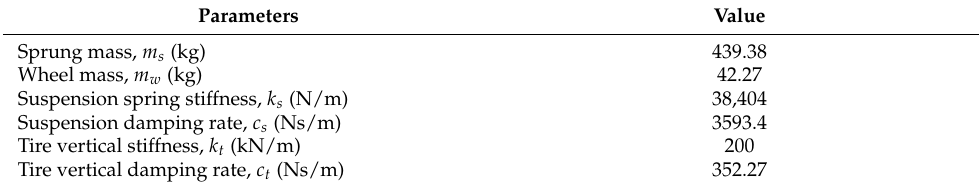
Table 1. Physical parameters of a quarter-vehicle model.